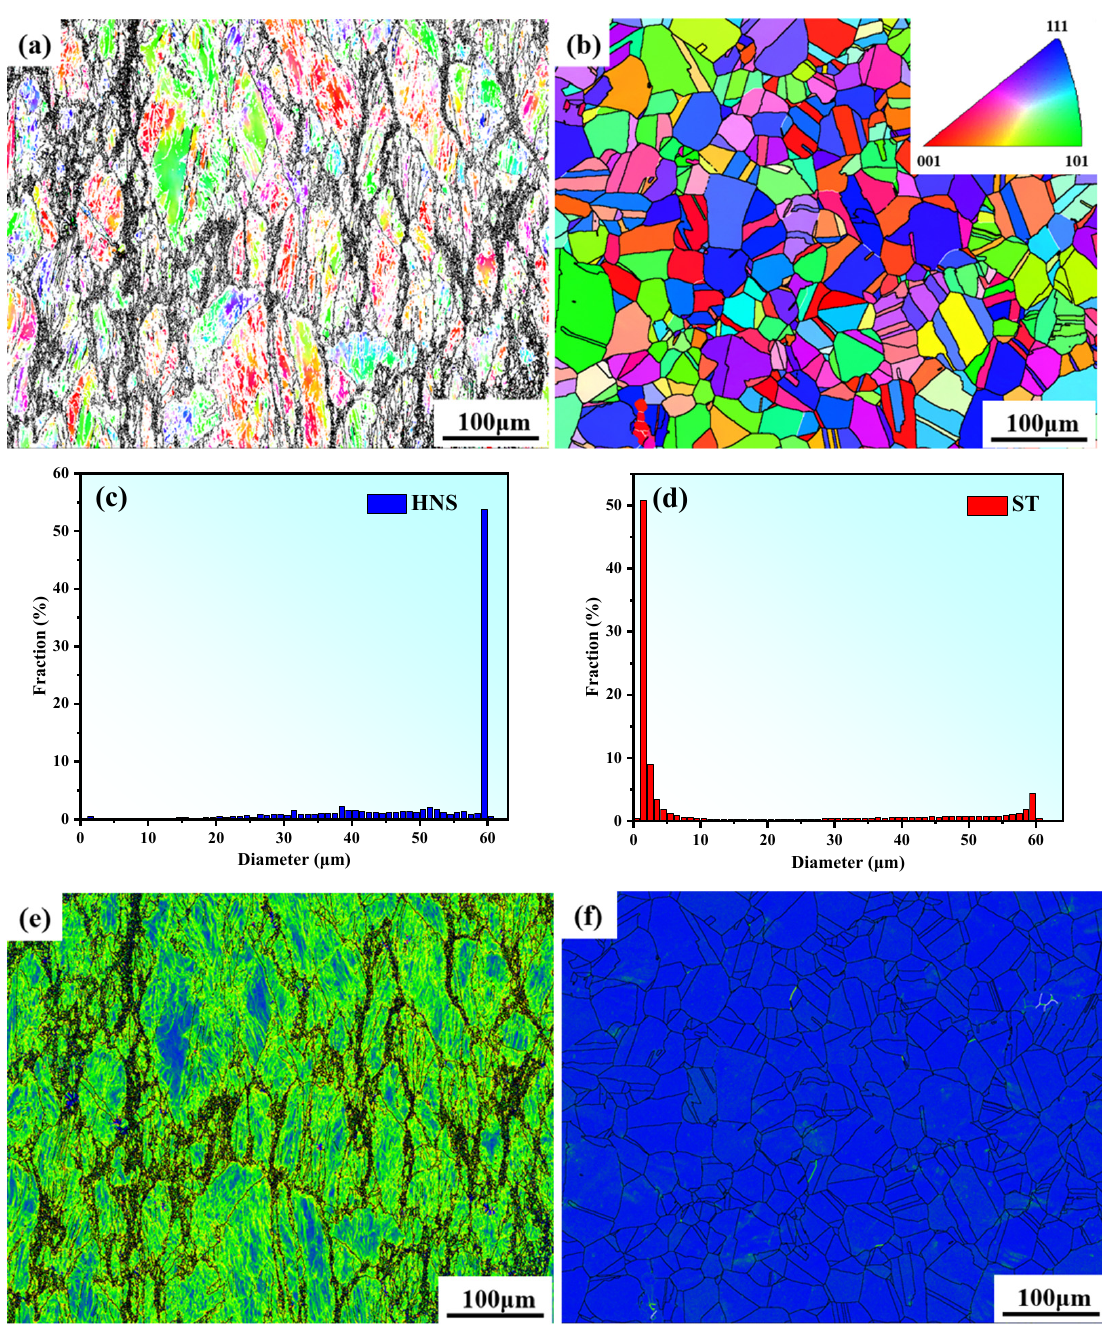
Figure 2. Inverse pole figures of ( a ) HNS, ( b ) ST; grain size distribution of ( c ) HNS, ( d ) ST; KAM diagrams of ( e ) HNS, ( f ) ST.